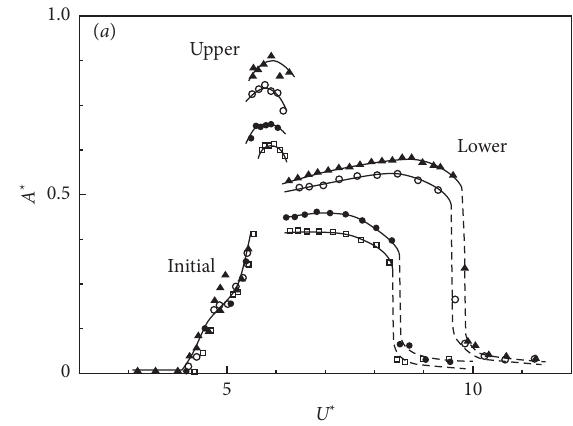
Figure 12: Amplitude response plots at a constant Reynolds number ( Re ≈ 4000 ) at different mass damping values ( m ∗ + C ) ζ � α � 0 . 000 ; 0 . 059; 0 . 187; 0 . 252, taken from Govard- A han and Williamson [28]. ▲ , α � 0 . 000; ○ , α � 0 . 059; ● , α � 0 . 187; □ , α � 0 . 252.